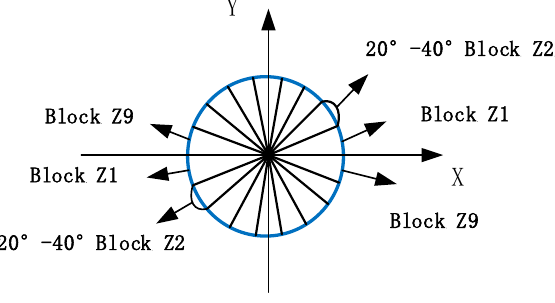
Figure 3. Diagram of cell segmentation.